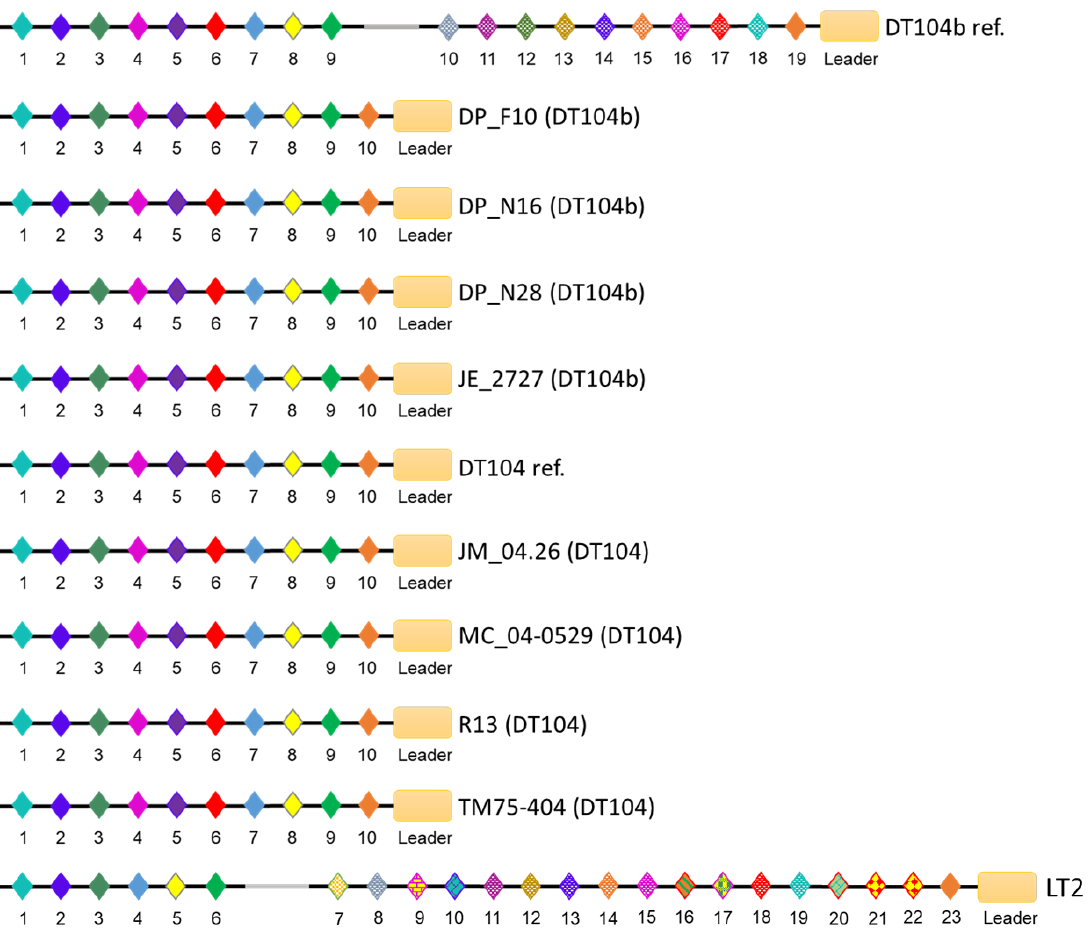
Figure 3. Schematic representation of CRISPR-1 locus in S . Typhimurium. The direction of spacers and repeats is shown, 5’ → 3’, with respect to the leader region (orange rectangle). The palindromic repeats (CGGTTTATCCCCGCTGGCGCGGGGAACAC) are shown as black horizontal lines. A distinctly coloured diamond represents each spacer. Spacer sequences and length were commonly shared between the DT104b and DT104 S . Typhimurium genomes, only with spacer variation in the DT104b reference (DT104b ref.) strain that possesses nine unique (in respect to all other strains) spacers represented as numbers 10–18. Additionally, n = 15 spacers in the DT104b reference genome and n = 7 spacers in the genomes of DP_F10, DP_N16, DP_N28, JE_2727, JM_04.26, MC_04-0529, R13, TM75-404, and DT104 ref. are identical to the spacers within the LT2 CRISPR-1 array.